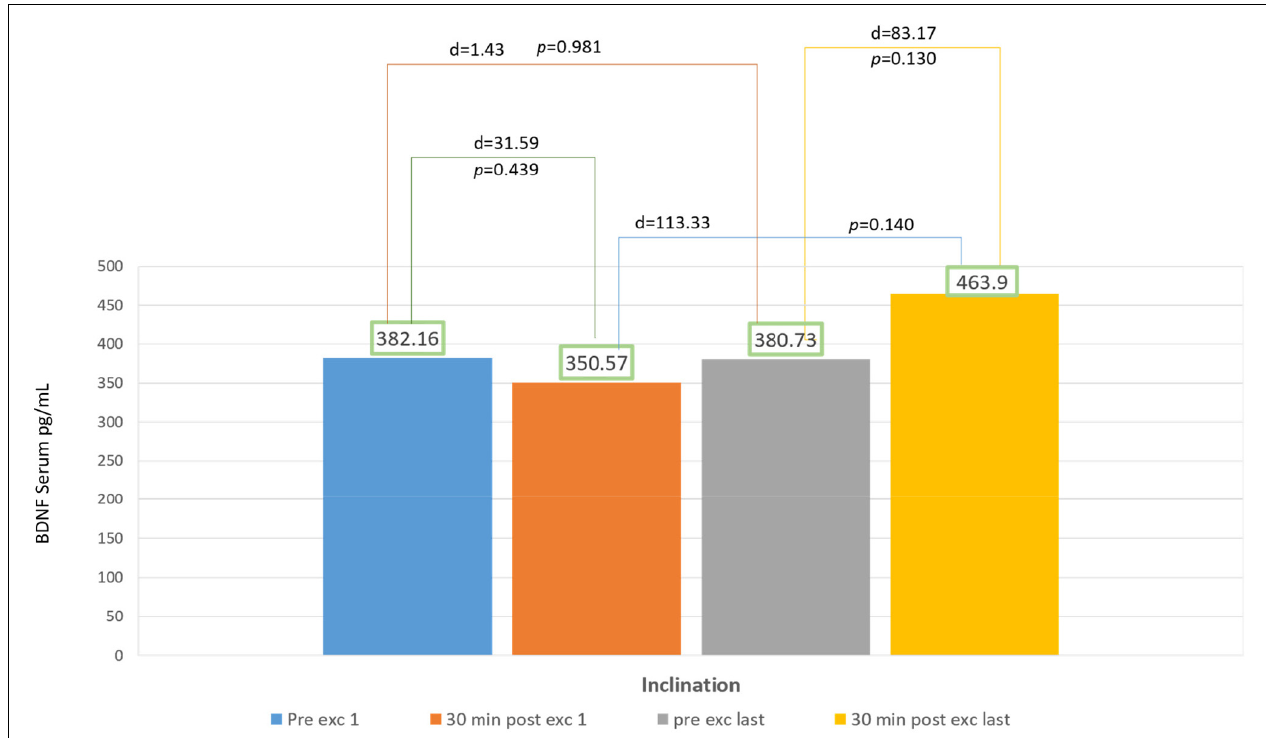
FIGURE 3 | Brain derived neurotropic factor (BDNF) serum result in inclination